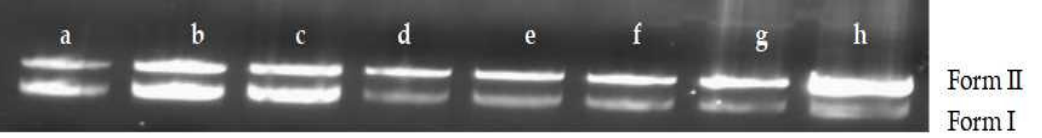
Figure 7. The direct break effect of MA on pET-28a DNA. Form II (open circular DNA and linear); Note: Form I (supercoiled DNA); a: 100% ethanol; b-h: 0.003906 mg/mL; 0.007812 mg/mL; 0.15625 mg/mL; 0.3125 mg/mL; 0.625 mg/mL; 1.25 mg/mL; 2.5 mg/mL.